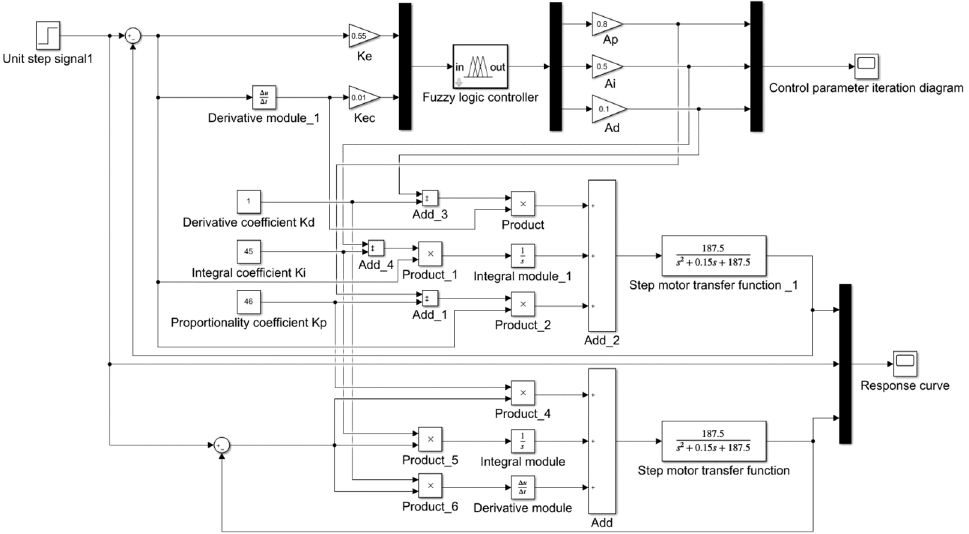
Figure 5. Unit step response simulation model for control systems.